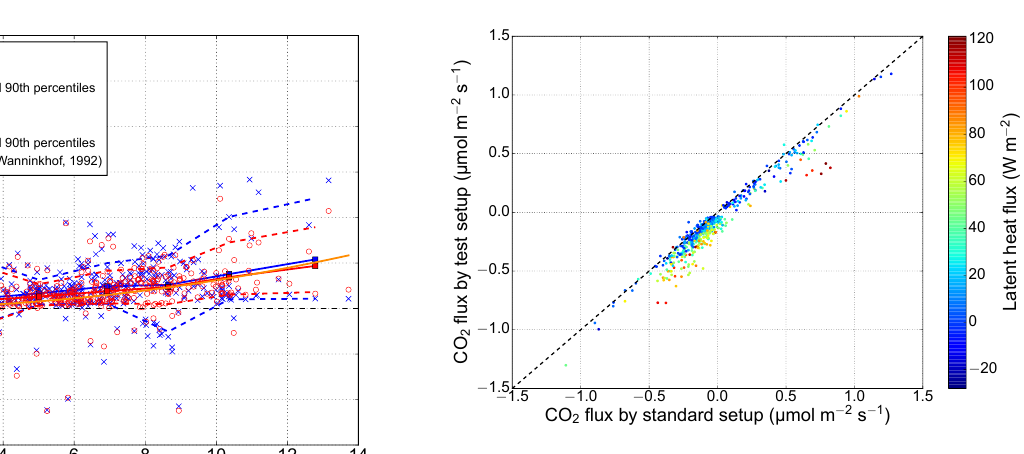
Figure 9. The sea–air CO 2 flux measured with the standard setup vs. the test setup (equipped with a drier and a virtual impactor). The marker color indicates the concurrent latent heat flux, and the dashed line represents the 1 : 1